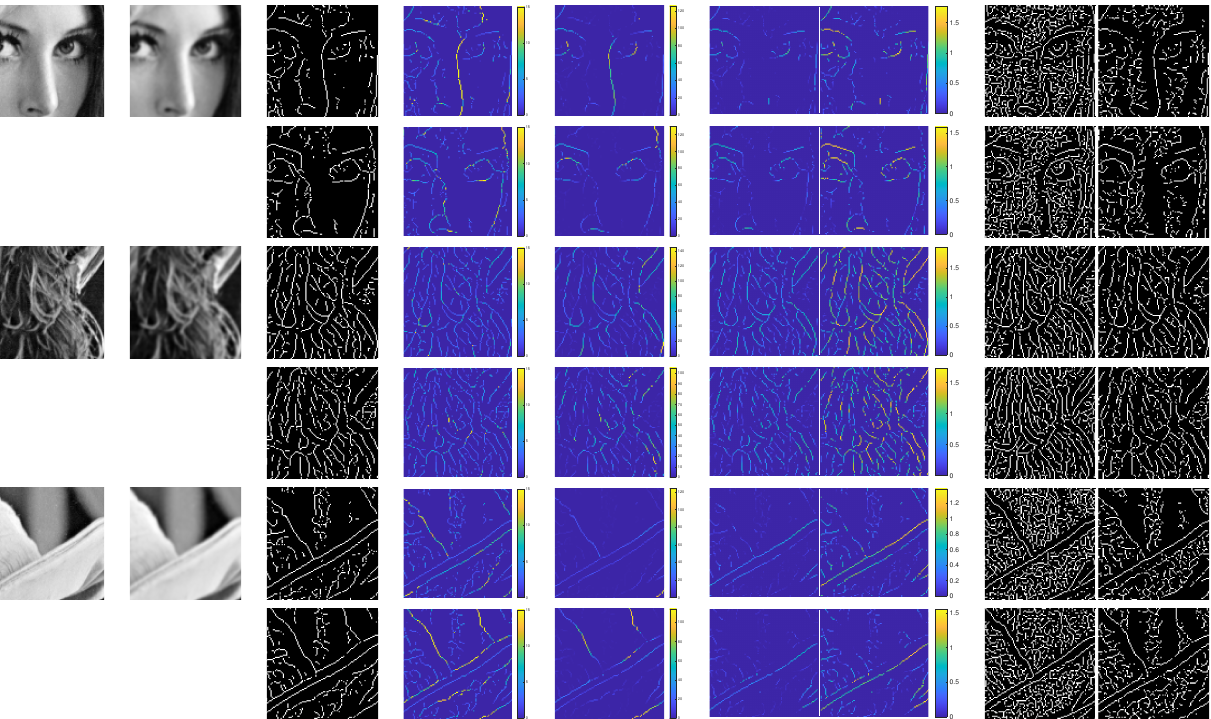
Figure 10. Line detection results for the Lena subset images. First to last columns show the original images, smoothed ( SNR ) of the SD- and SGAD-based line detections when images, ground truth line pixels, line width w , contrast k , log 10 σ n = 8.0, and line pixels detected by the SD- and SGAD-based line detections under σ n = 8.0. First, third, and fifth rows show the results for ridges and second, fourth, and sixth row show the results for